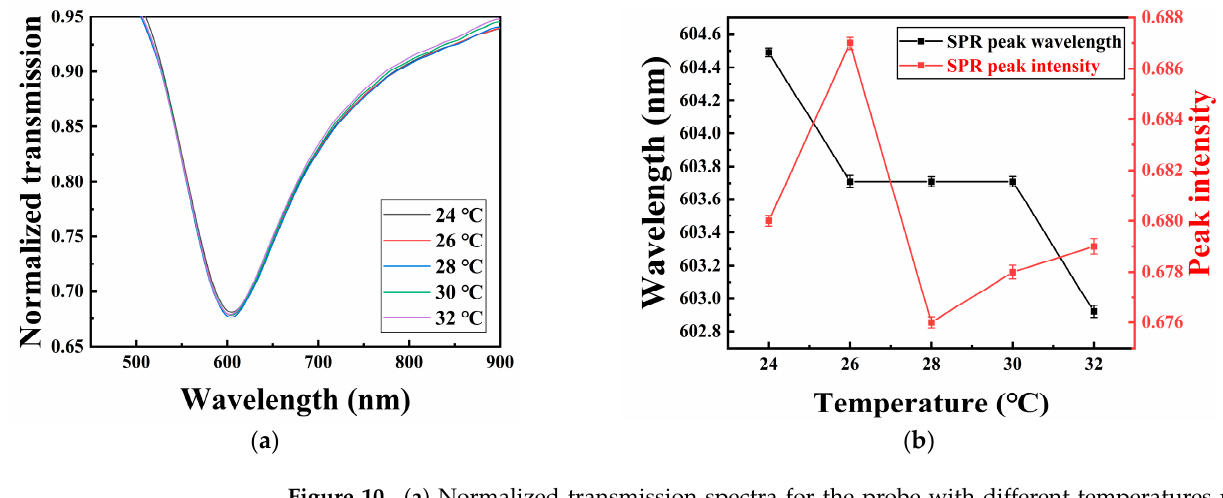
Figure 10. ( a ) Normalized transmission spectra for the probe with different temperatures rang- ing from 24 to 32 ◦ C; ( b ) The changes in SPR peak wavelengths and transmission intensities at different